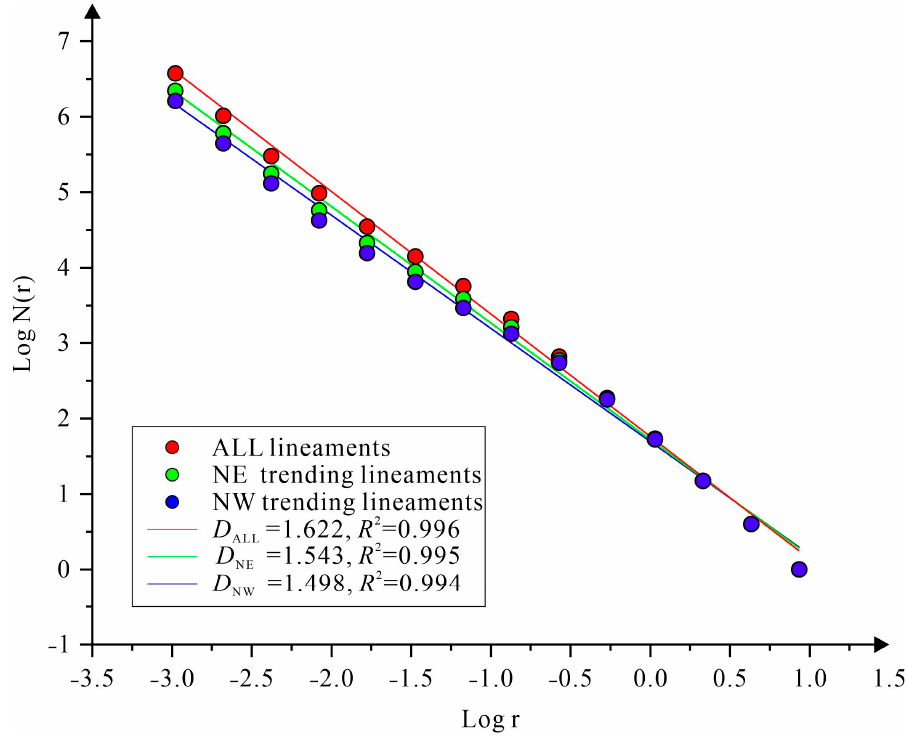
Figure 6. The fractal dimension of lineaments in the study area.